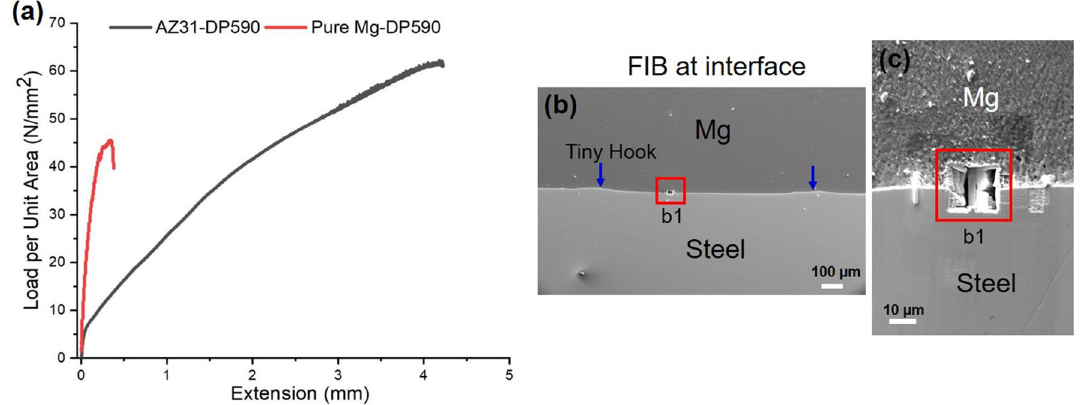
Figure 1. Joint strength and FIB. ( a ) Load per unit area VS extension plot for AZ31-DP 590 and pure Mg-DP 590 joints; ( b ) and ( c ) FIB micrographs at